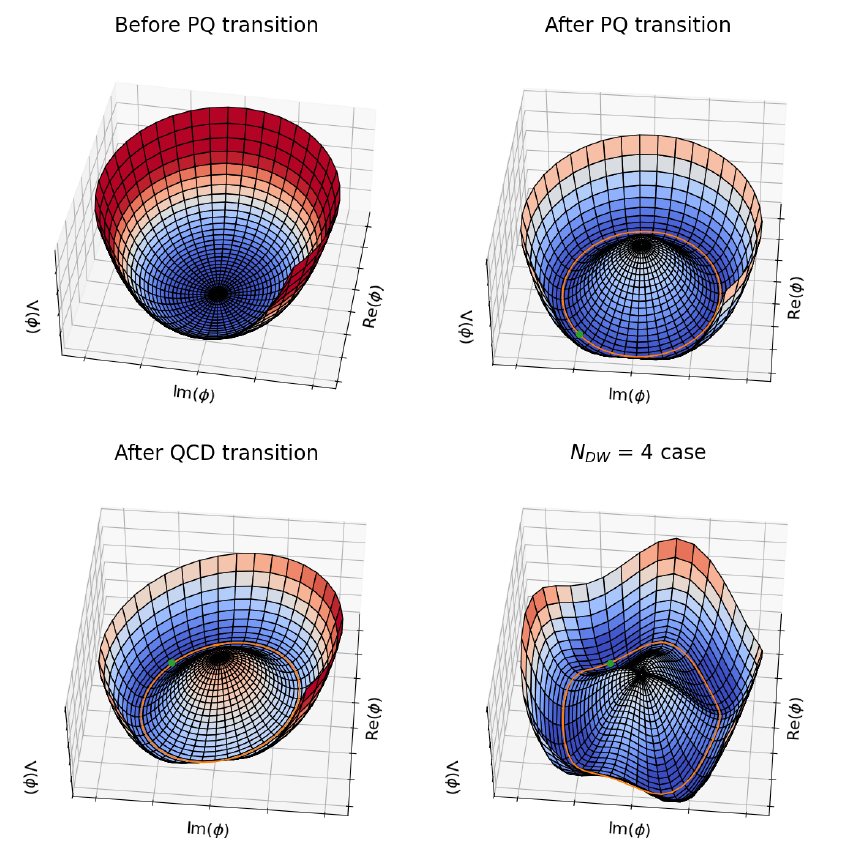
Figure 2: These figures schematically illustrate the evolution of the potential of the complex scalar field Φ whose phase is identified as the axion. When the Universe’s temperature decreases below the PQ scale the minimum of the potential shifts to a non-zero value for | Φ | , i.e. V ( Φ ) adopts the characteristic “mexican hat” shape (top-right). The energy-breaking scale corresponds to the radius of the valley from the centre. The Φ field sits at one point in the valley, i.e. it gets a VEV, and the PQ symmetry is spontaneously broken. The valley is however flat in the angular, that is, axion, dimension. Therefore, the initial value of the axion field (illustrated as the green dot) takes a random value in [ − π , π ). At lower temperatures, QCD effects give a mass to the axion and make the potential “tilt” (bottom-left). There is now a preferred value for the axion field which turns out to be the CP-conserving value. In some models, more than one such minimum exist (bottom-right shows the N case). When the temperature falls below QCD, the axion falls from wherever it was down to this minimum, and starts oscillating around it. These oscillations fill the space and behave as dark